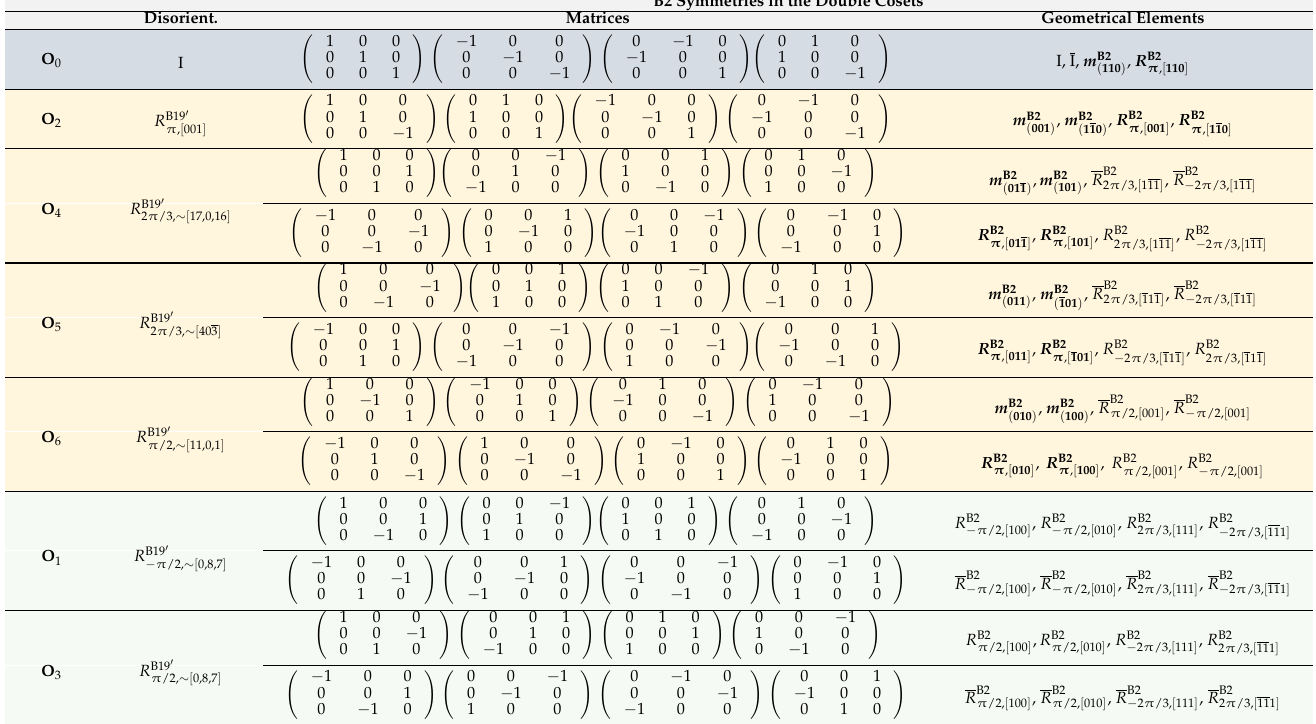
Table 2. List of operators for the B2 → B19 (cid:48) transformation. The operators are numbered from 0 (identity operator) to 6; the order results from the double-coset decomposition made in GenOVa. The operators are classified here into three categories: the neutral operator O 0 ; the ambivalent operators { O 2 , O 4 , O 5 and O 6 } and the complementary polar operators { O 1 and O 3 } . The second H B2 g B2 T . The third and column gives the disorientation, i.e., the smallest rotation in the set T − 1 H B2 j T T fourth columns give the B2 symmetries g B2 in the double cosets by their matrices and by symmetry j elements, respectively. The elements in bold are two-fold symmetries. B2 Symmetries in the Double Cosets Disorient. Matrices Geometrical